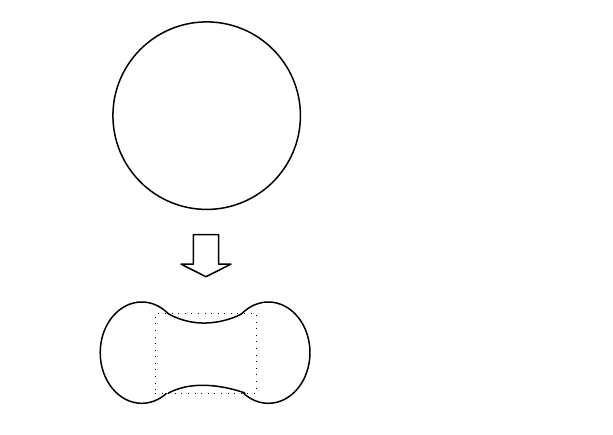
Figure 4 . The construction of the \dumbbell" like black hole solution from the spherically sym- metric black